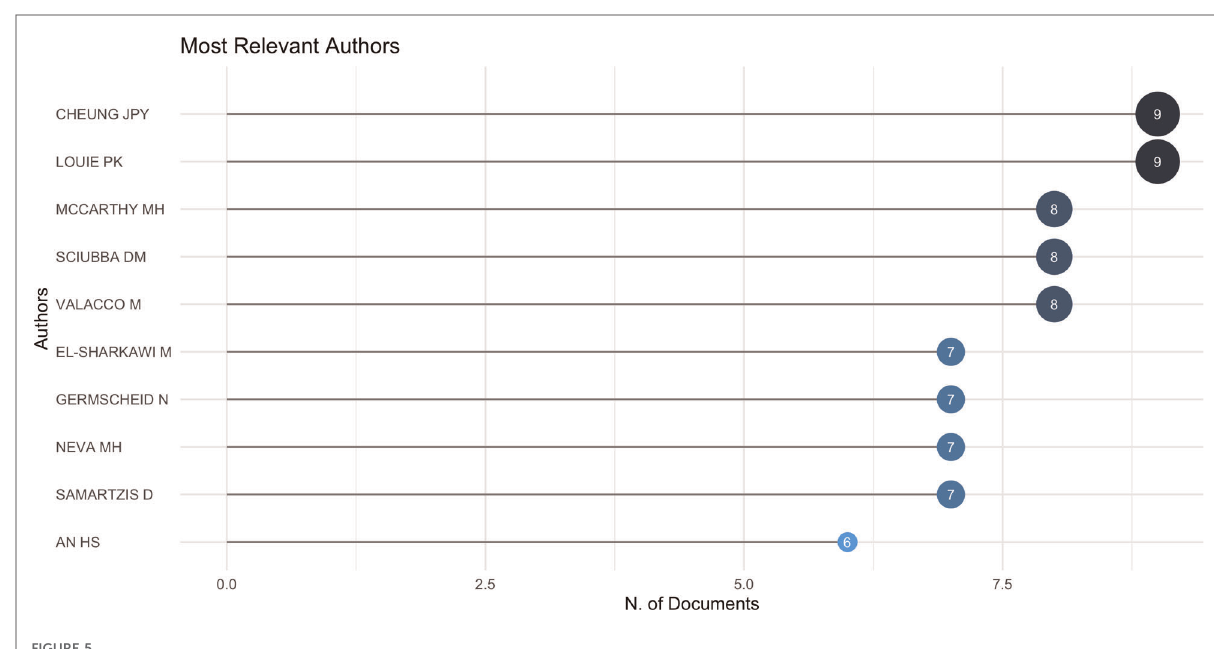
FIGURE 5 Top 10 authors with the highest number of publications in the fi eld of spine surgery and COVID-19 (generated by